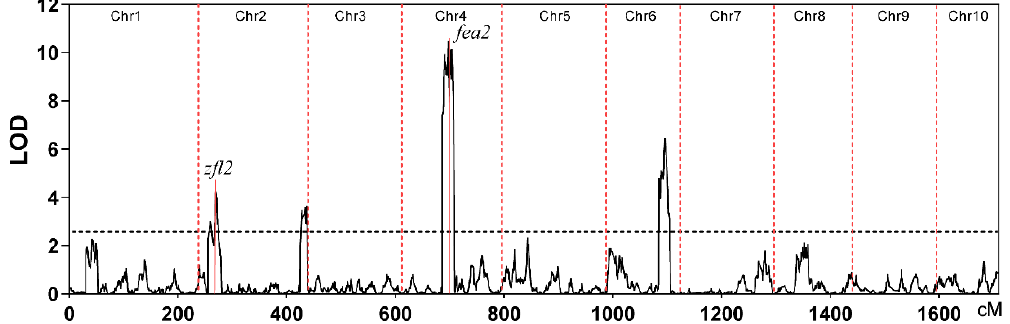
Figure 1. QTLs detected for TBN in the B73 × CML247 RILs population. zfl2 and fea2 were colocated with qTBN2a and qTBN4 , respectively. Table 1. List of QTL for TBN in the B73 × CML247 RILs population.